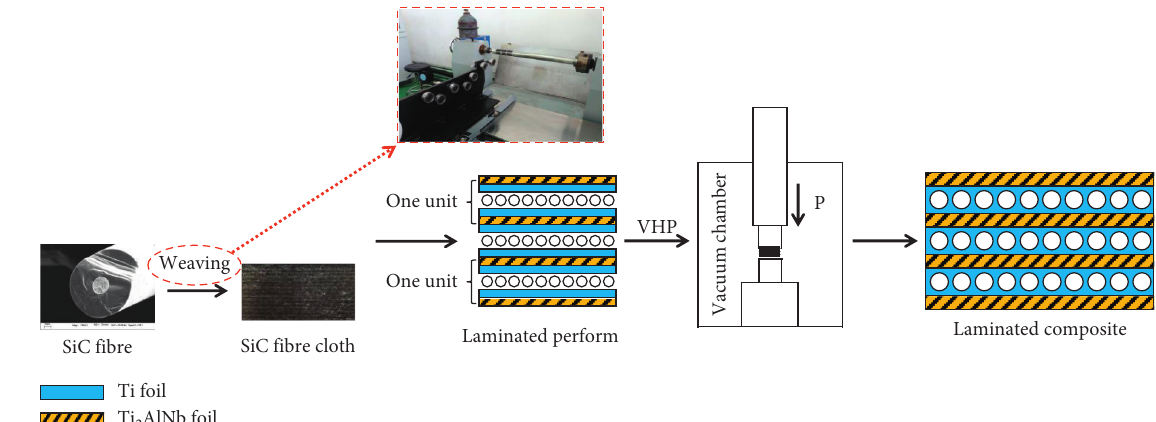
Figure 1: Schematic diagram for the hot-pressing fabrication of the